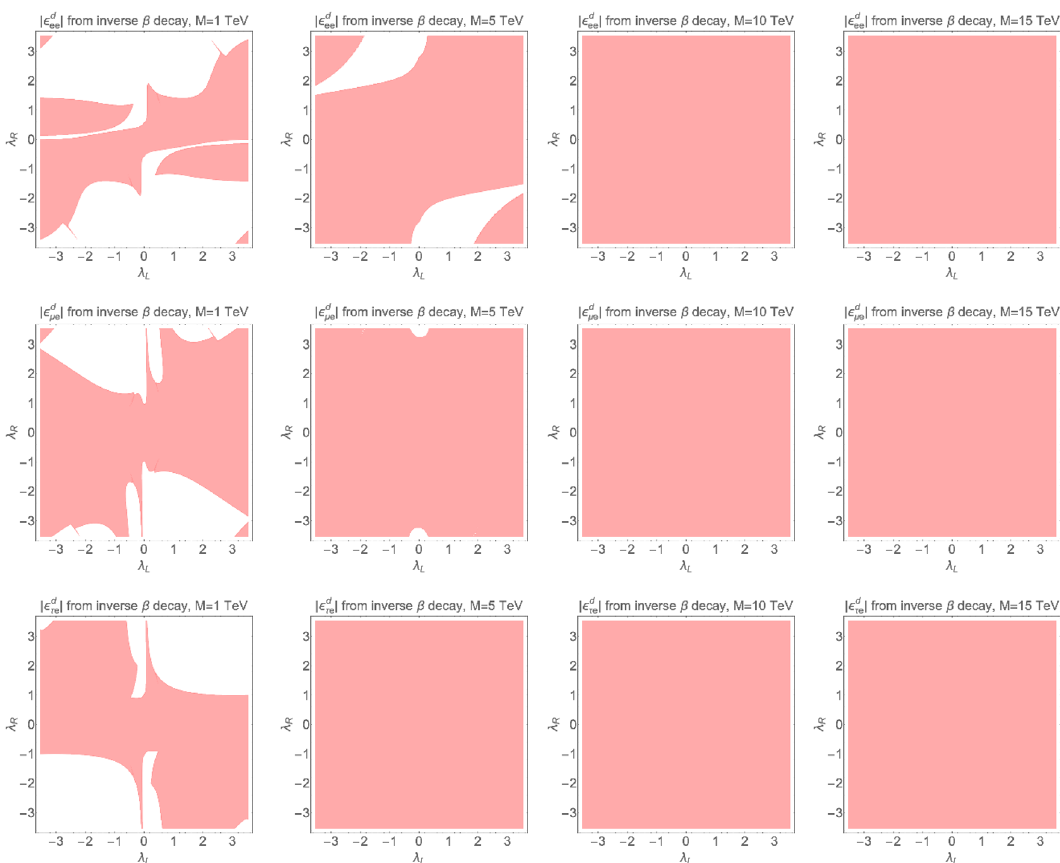
Figure 6 . Constraints on the simplified leptoquark model parameter space from current constraints on | (cid:15) d | ( ‘ = e, µ, τ ) from inverse beta decay summarized in table 4. The pink region(s) in ‘e